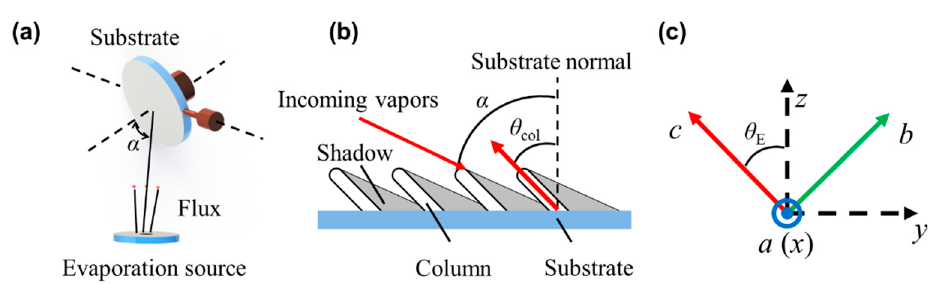
Figure 1. ( a ) Schematic diagram of the glancing angle deposition (GLAD) method for electron beam evaporation, ( b ) columnar thin film fabricated by the GLAD method, and ( c ) the laboratory coordinate system ( x , y , z ) and the principal coordinate system ( a , b , c ).